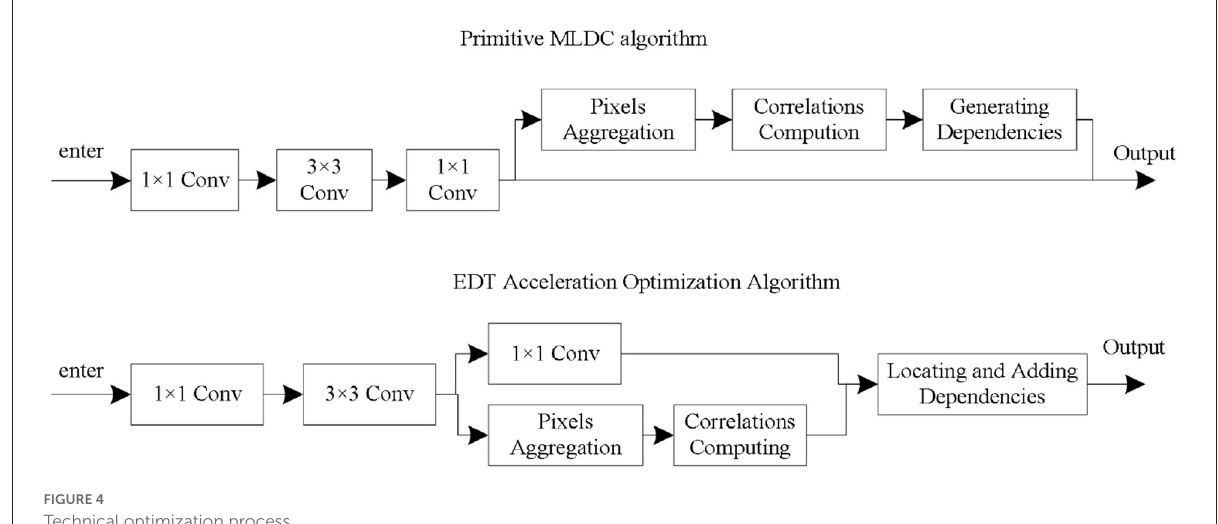
FIGURE4 Technical optimization